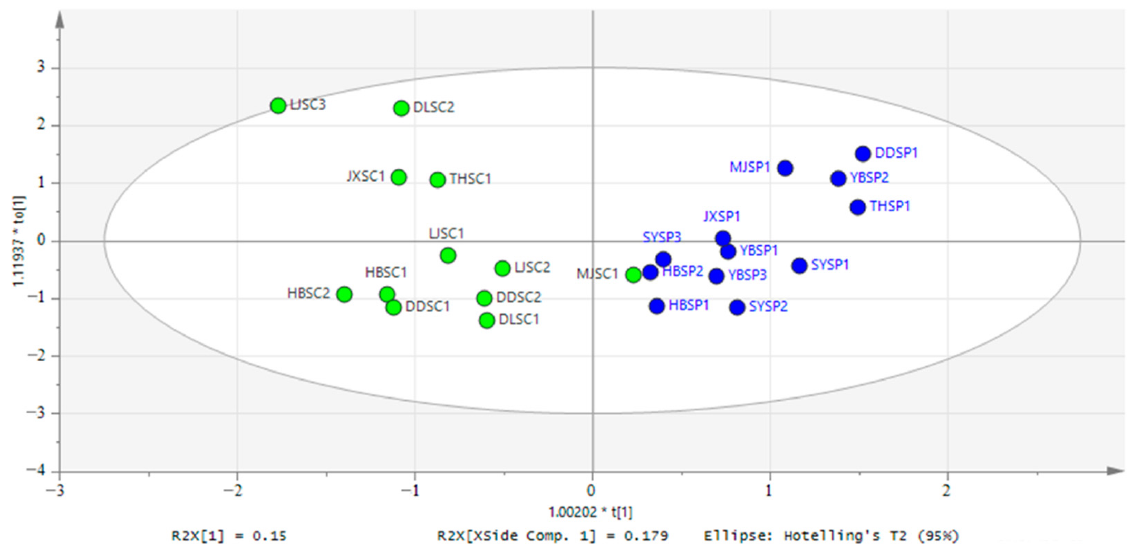
Figure 1. Biplot of the OPLS-DA on the Chemical analysis in different types (A: Group_P: retail packaging, Group_C: home-made, R 2 X = 0.492, R 2 Y = 0.8, Q 2 = 0.67).